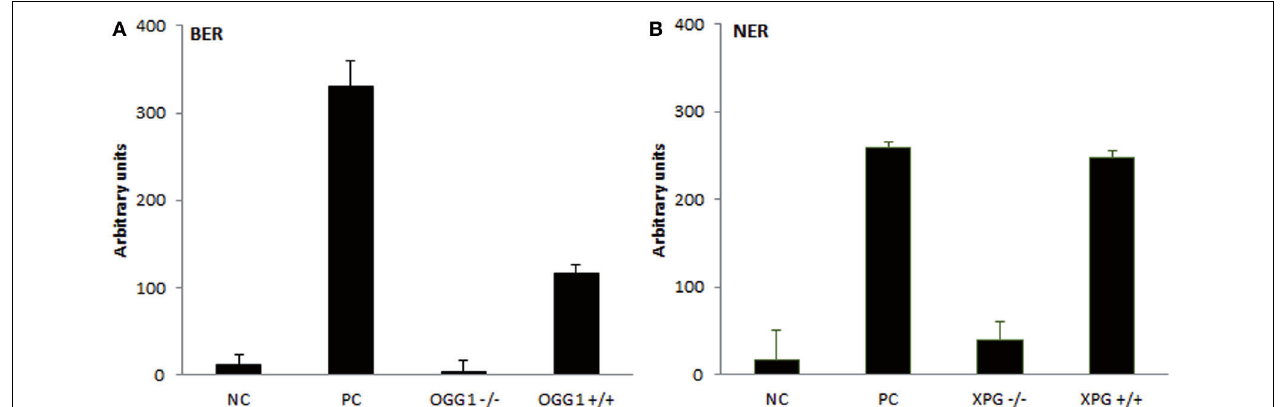
incubationwithbufferonlyandpositivecontrol(PC)incubationwithFpg.For (B) NER assay extracts were isolated from XPG − / − and XPG + / + hamster ovarian cancer cells CHO AA8, and NC and PC represent incubation with buffer and Endo V, respectively. Data represent means ± SD of duplicate measurements.